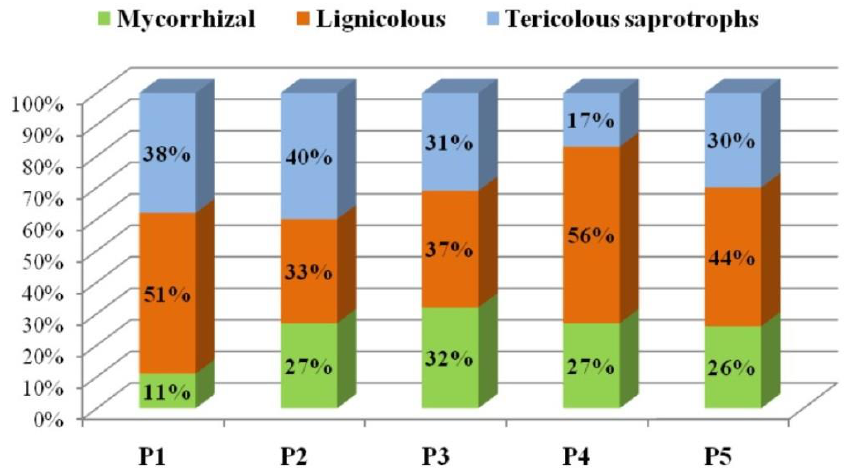
Figure 3. Functional diversity of macrofungi within different forest habitats.